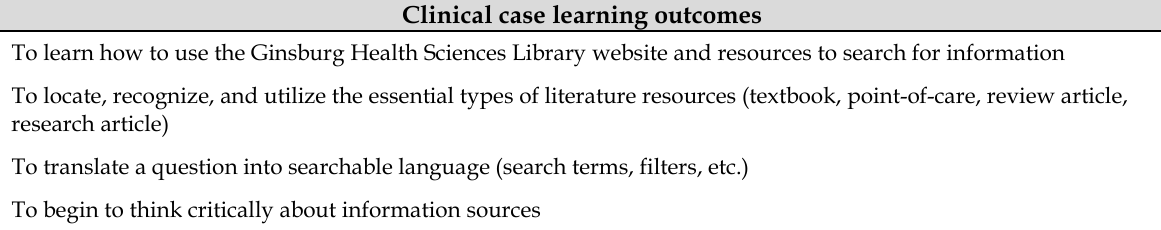
Table 3 Medical faculty member–written clinical case learning outcomes Clinical case learning